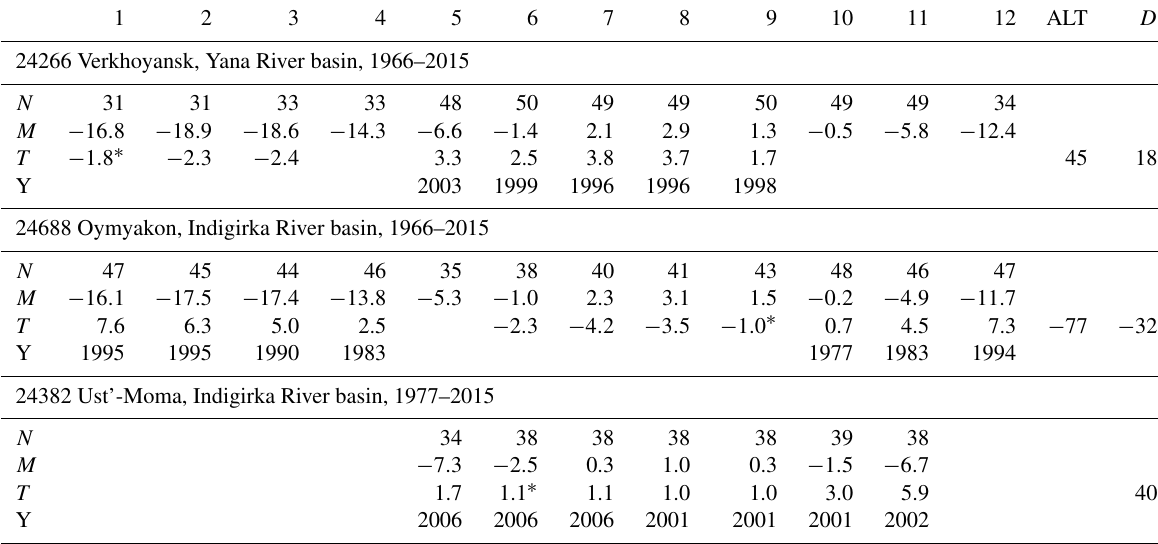
Table 6. Changes in soil temperature at 80cm of depth and maximum active layer thickness (ALT).